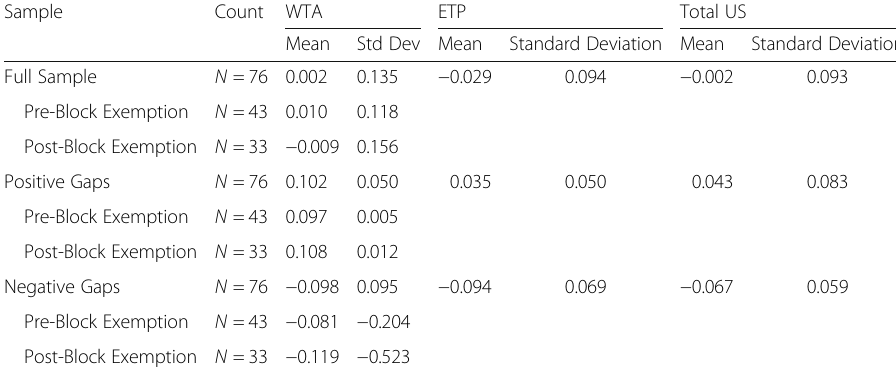
Table 1 “ Gap series ” statistics pre- and post block